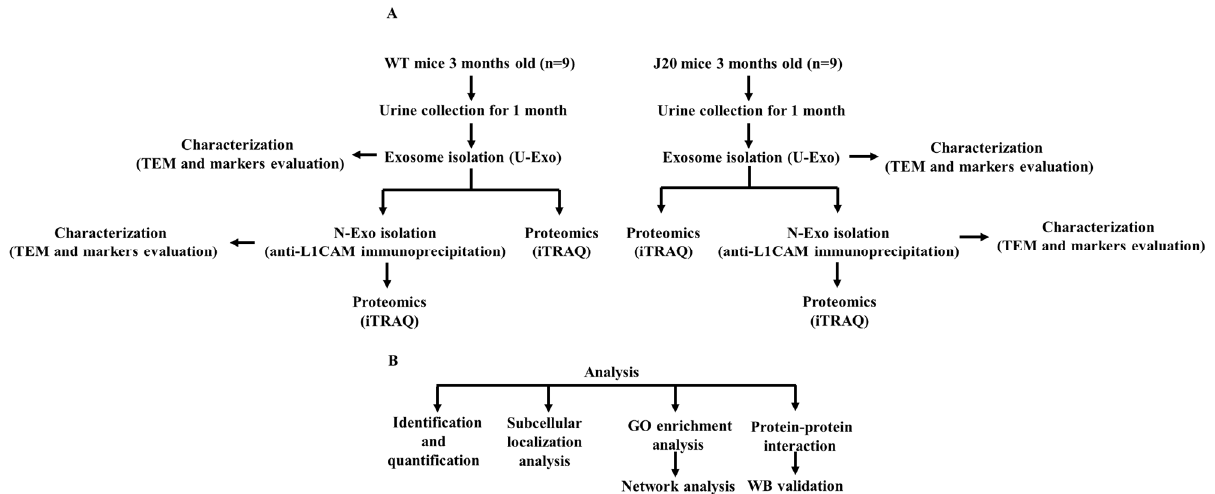
Figure 10. Workflow of experiment design. ( A ) Isolation, characterization, and proteomics of urine exosomes (U-exo) and neuron-derived exosomes (N-exo) in male mice with the human amyloid precursor protein (hAPP) transgene (J20) and their wild-type (WT) littermate control. First, the U-exo was isolated from urine by polymer precipitation, then N-exo was isolated from U-exo by immunoprecipitation with the anti-neural cell adhesion molecule L1 (L1CAM) antibody. Second, the two exosomes were characterized by transmission electron microscope (TEM) and Western blotting (WB). Lastly, the protein profiles of U-exo and N-exo were identified using isobaric tags for relative and absolute quantitation (iTRAQ)-based matrix assisted laser desorption ionization time of flight mass spectrometry/mass spectrometry (MALDI TOF MS/MS). ( B ) Bioinformatics analysis and protein validation. The identified proteins were analyzed by bioinformatic analysis. Then, the most important proteins screened by bioinformatics were validated by